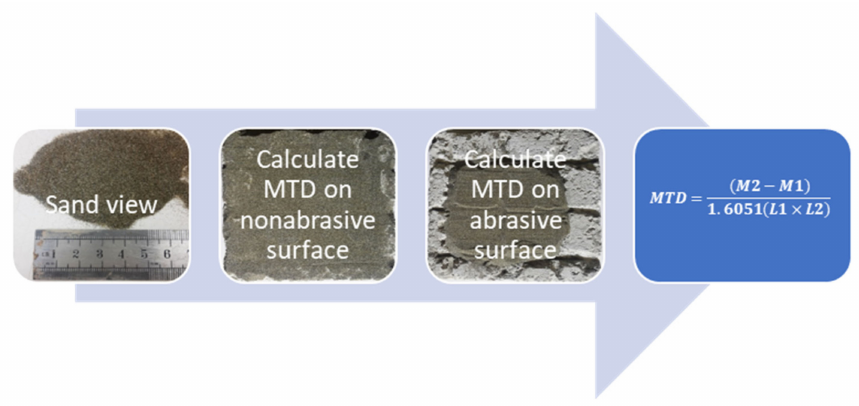
Figure 6. Measuring the MTD on abrasive or nonabrasive RCC